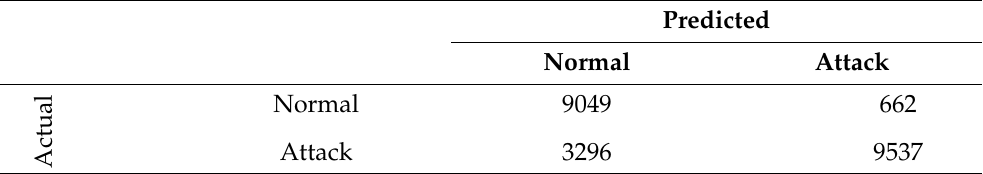
Table 6. Confusion matrix for NSL-KDD “full features” binary classification